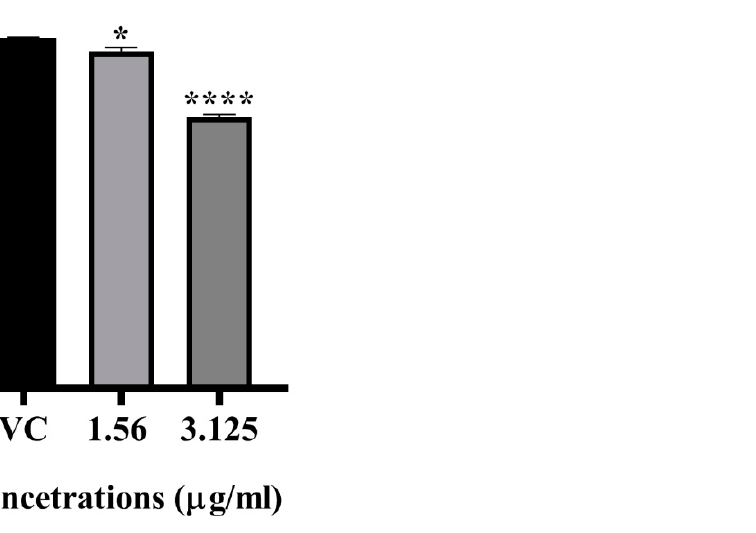
Figure 3. Dose dependent effect of LFOB on DENV-2 as assessed via focus forming unit assay. All the values are expressed as mean ± SD of three experiments. **** p < 0.0001; * p < 0.05 vs. control.